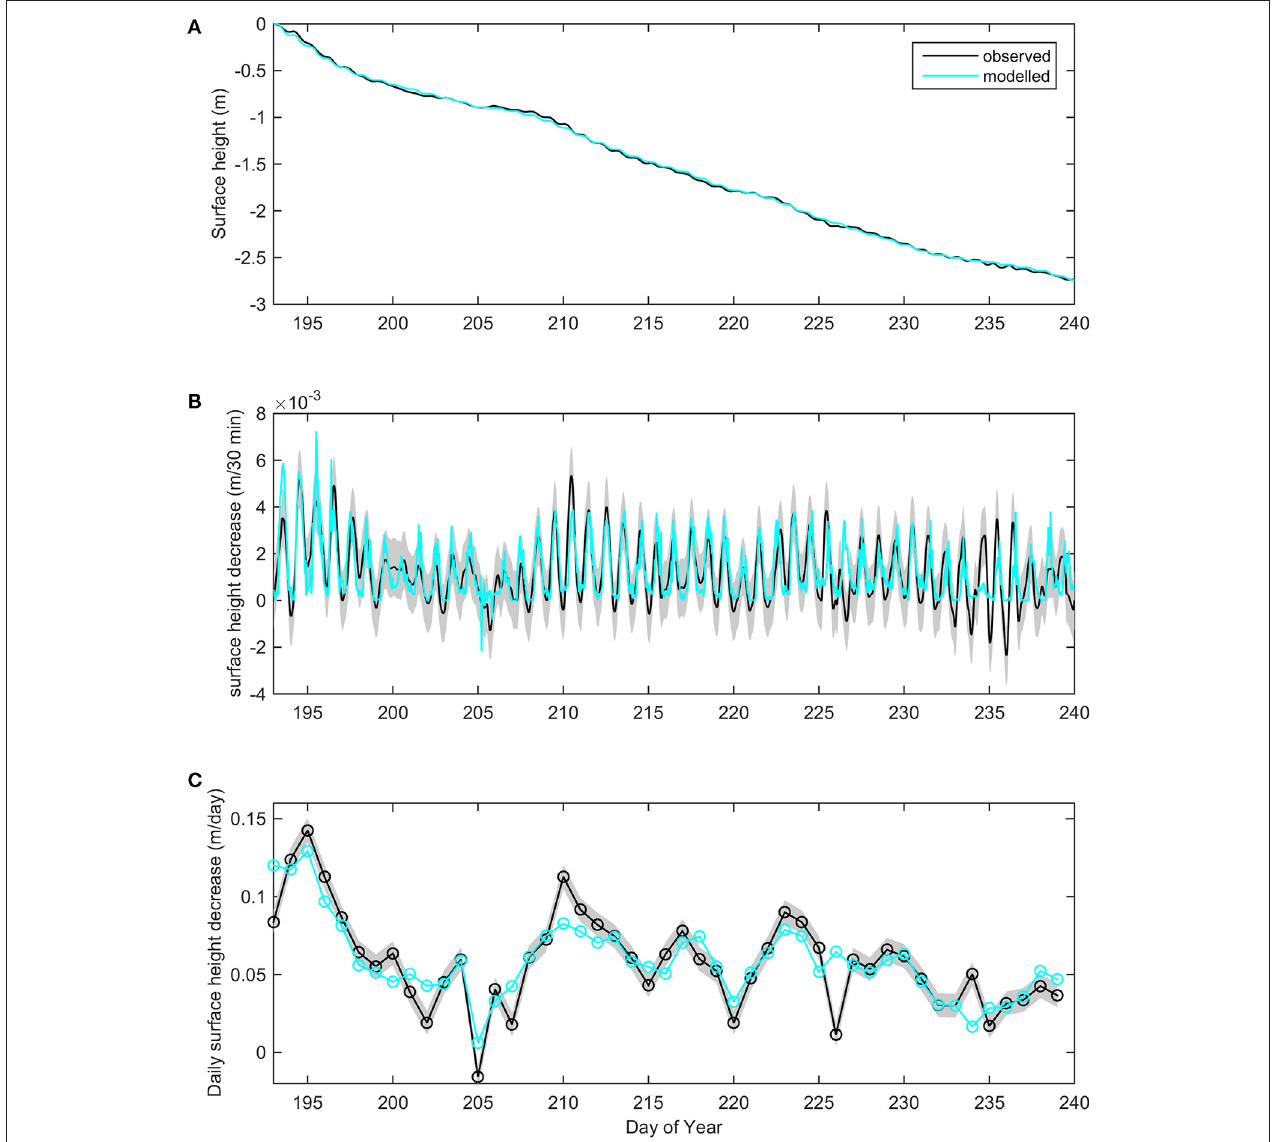
FIGURE 4 | Observed (black) and modeled (cyan) surface height changes due to ablation/accumulation on Nordic Glacier, summer 2014; (A) surface height trend over the season, (B) 30 min rate of surface height change, and (C) daily rate of surface height change (midnight to midnight). The gray shading represents the uncertainty in the observed surface height values arising from the choice of moving average filter length when processing the sonic ranger